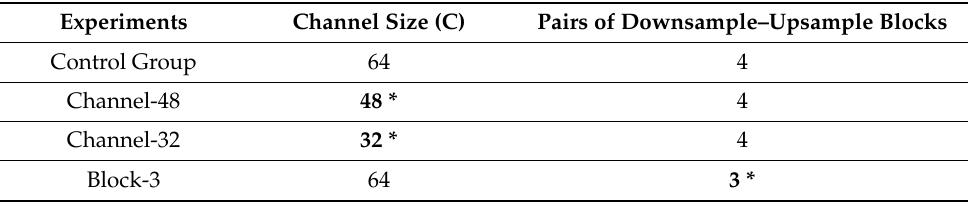
Table 2. Ablation study setup of the proposed LUSwin transformer. Experiments Channel Size (C) Pairs of Downsample–Upsample Blocks Control Group 64 4 Channel-48 48 * 4 Channel-32 32 * 4 Block-3 64 3